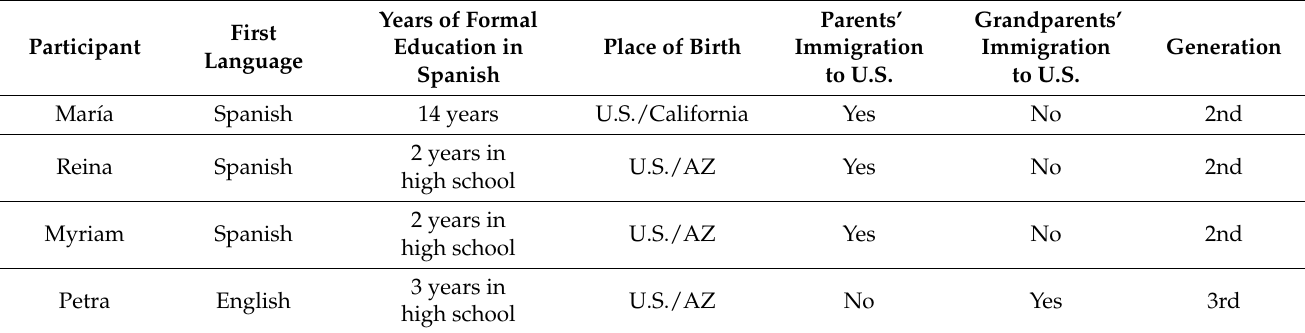
Table 1. SHL Participant Language Background Information.